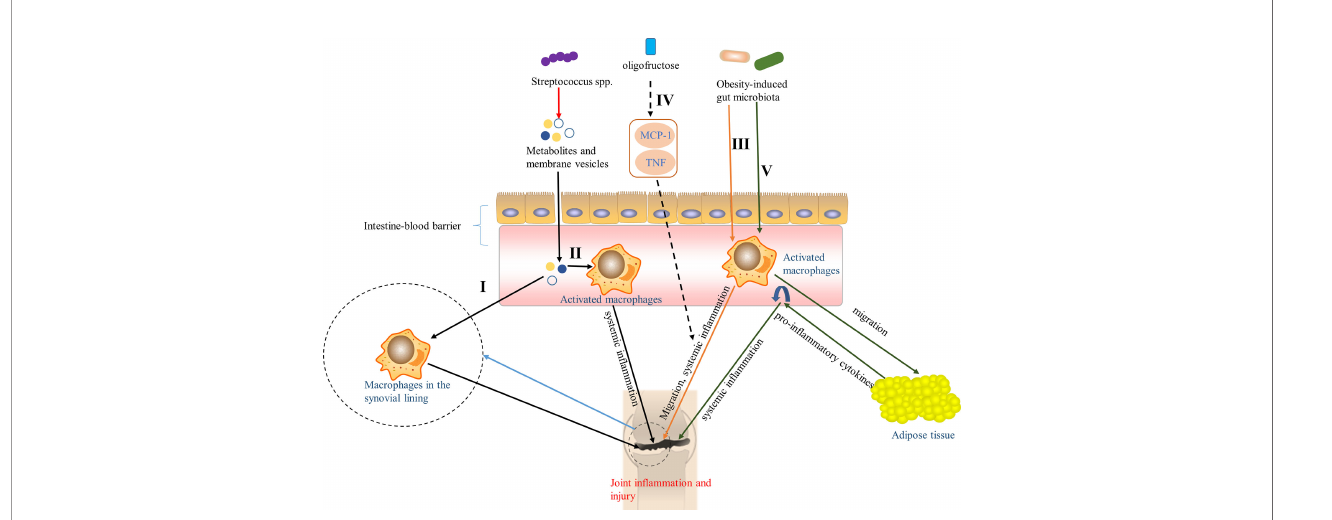
FIGURE 2 | Pathways of the effect of gut microbiota on OA via macrophages. I Metabolites and membrane vesicles produced by Streptococcus spp. caused joint in fl ammation and injury by passing through the intestine-blood barrier to activate macrophages in the synovial lining (Boer et al., 2019). II Metabolites and membrane vesicles in the circulation, produced by Streptococcus spp., activated macrophages to pro-in fl ammatory macrophages and triggered a low-level systemic in fl ammatory state that aroused or aggravated joint in fl ammation and injury (Boer et al., 2019). III Obesity-induced gut microbiota accelerated knee OA by contributed to the systemic in fl ammation and the migration of macrophages to the synovium (Schott et al., 2018). IV Oligofructose, an indigestible prebiotic fi ber, can reversed the pathway in III through inhibiting the up-regulation of monocyte chemotactic protein 1 (MCP-1) and tumor necrosis factor (TNF) (Schott et al., 2018). V Obesity- induced gut microbiota activated in fl ammation (John and Mullin, 2016; Portune et al., 2017), causing activated macrophages to migrate to adipose tissue that released pro-in fl ammatory cytokines into the circulation (Weisberg et al., 2003; Xu et al., 2003; Lumeng et al., 2007), aggravating systemic in fl ammation, and promoting the development of